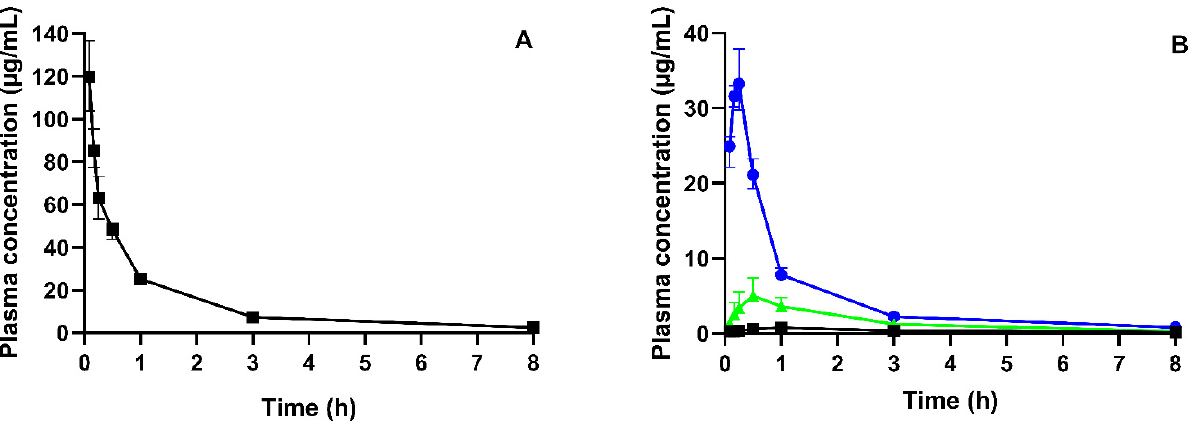
10 of 19 Figure 3. Biphasic dissolution experiment under mouse gut conditions; neat CorA ( □ ; solid line),